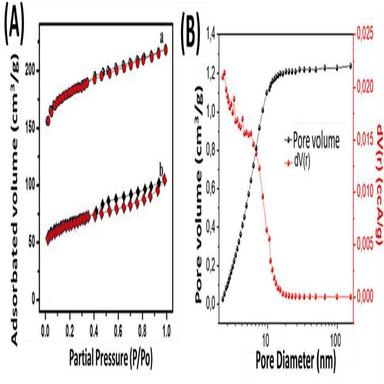
(A) N2 adsorption-desorption isotherms of carbon sample pyrolyzed under an inert nitrogen atmosphere and activated carbon samples activated with KOH chemical agent. (B) Pore size distribution of the KOH-activated hard carbon.